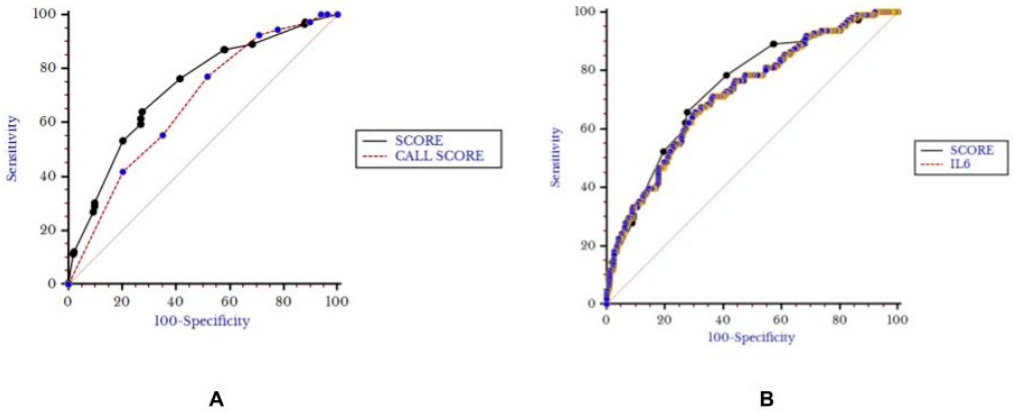
Figure 6. Comparison between Score and Call Score ( A ) and Interleukin-6 ( B ) for secondary out- come.